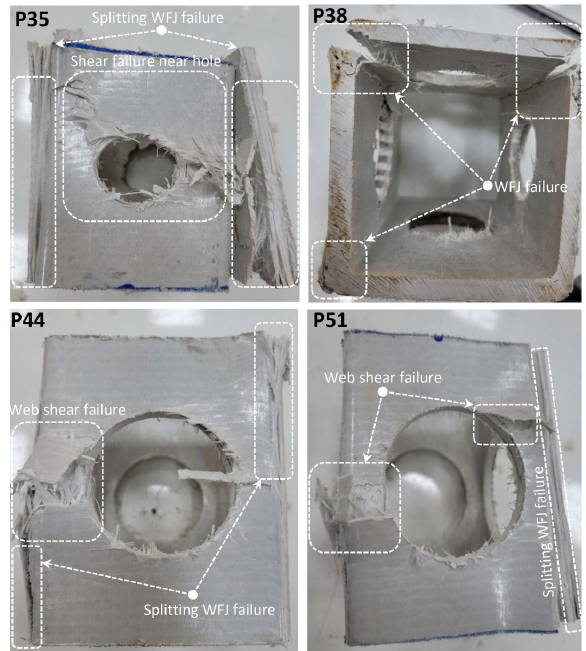
Figure 7. Damage analyses of P35, P38, P44, and P51.